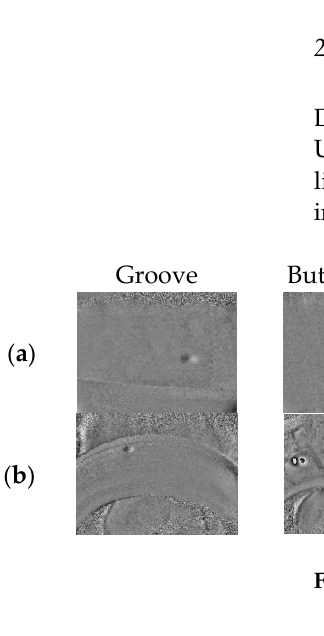
Figure 1. The bubble detection process.